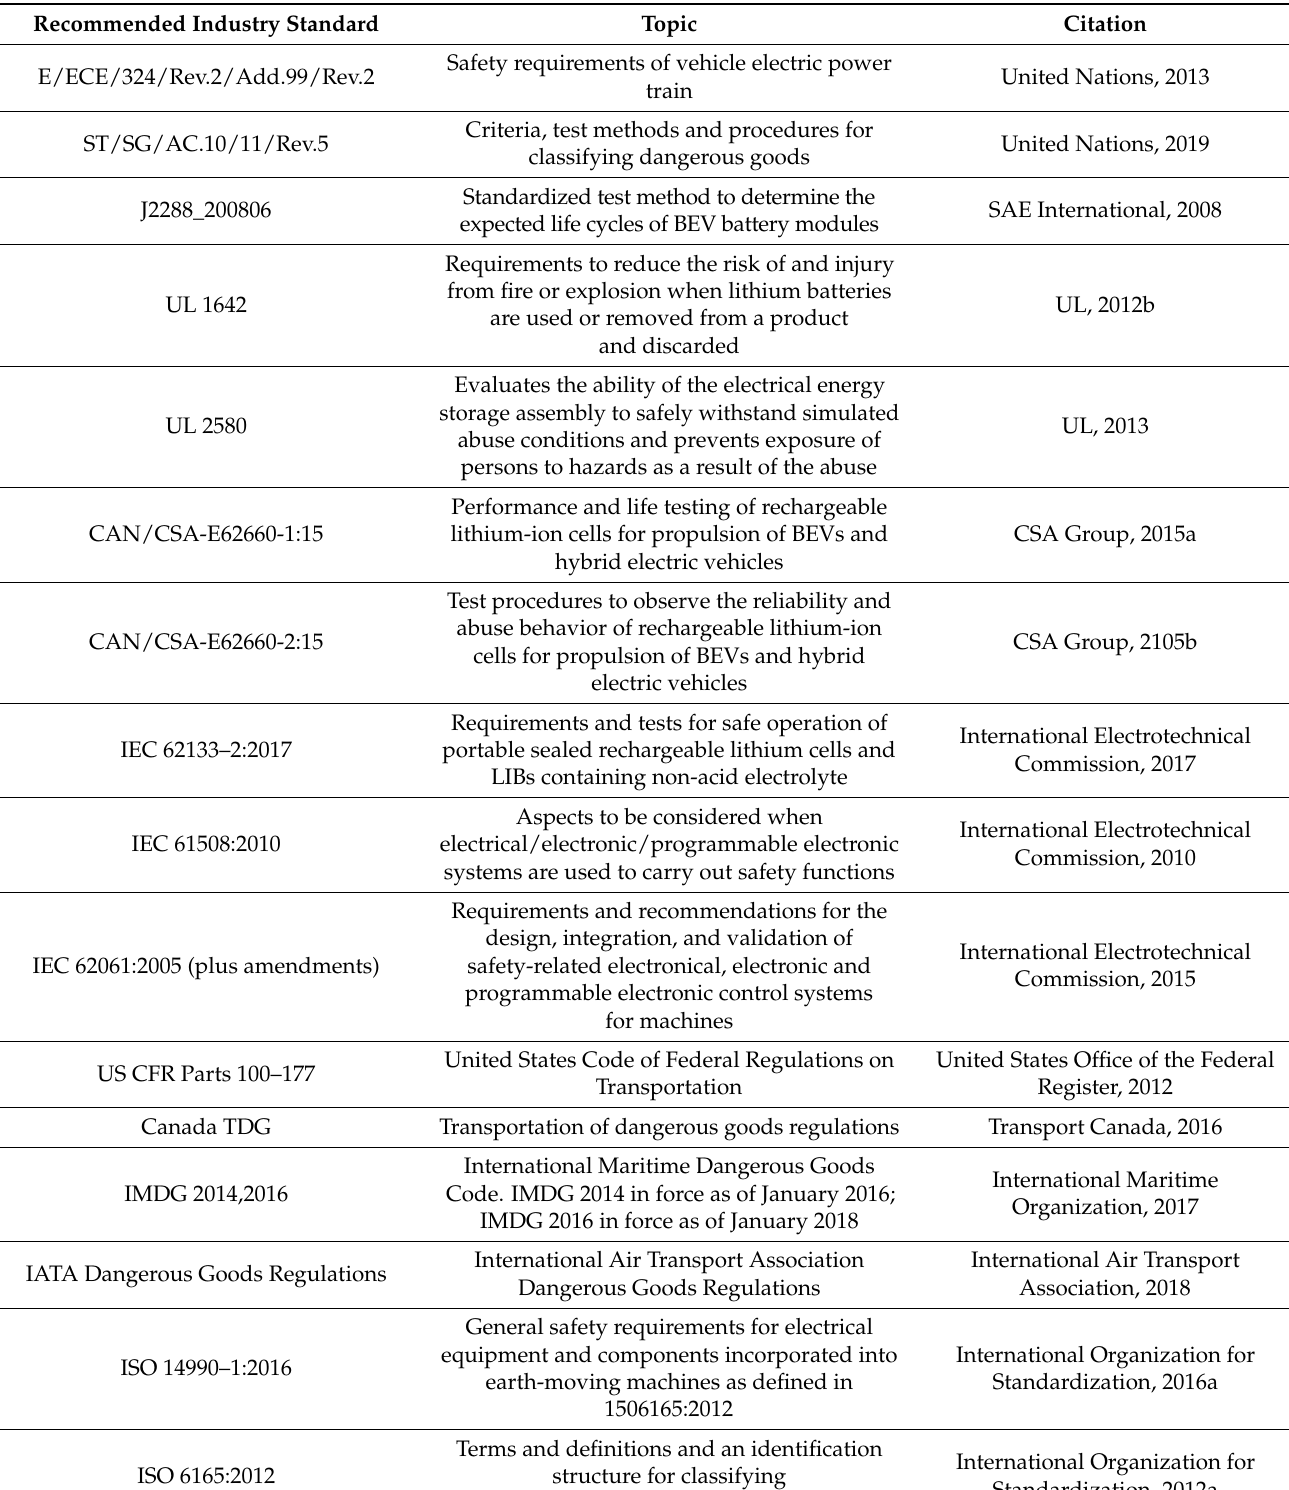
Table 8. Test standards for energy-storage